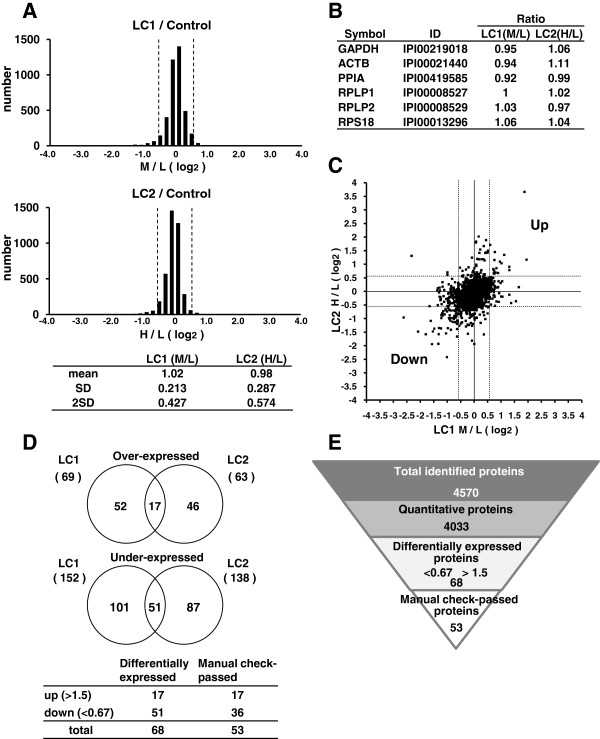
Statistical analysis of SILAC data of two patient cells. (A) Upper panels, log2 distributions of Medium (M)/Light (L) and Heavy (H)/Light (L) ratios of proteins quantified in SILAC analysis. Dashed lines represented log2 transformed cut-off values (>1.5, <0.67). Lower panel, statistical summary of ratios of two patient cells. (B) Ratios of various housekeeping proteins identified in SILAC analysis. (C) Scatter plot of log2 transformed patient cells/control cells ratios. X- and Y- axes represent log2 transformed M/L and H/L ratios, respectively, as indicated in the graph. (D) Upper panels, Venn diagrams show the number of overlapping altered proteins between the two patient cells. Lower panel, if there were only two quantified peptides, individual peptides must have met the cut-off value (>1.5 or <0.67) and proteins found not to meet this criteria were discarded. “Manual check-passed” represents remaining proteins after implementing the above criteria. (E) Summary of quantitative proteomics.